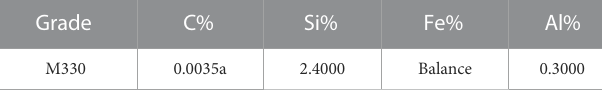
TABLE 2 Chemical composition of M330-35A samples.